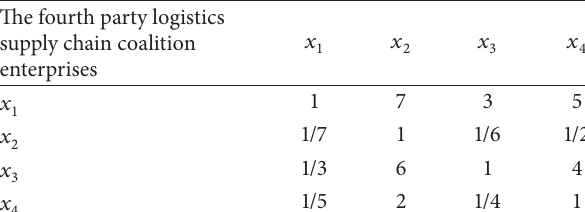
Table 1: Judgement matrix.